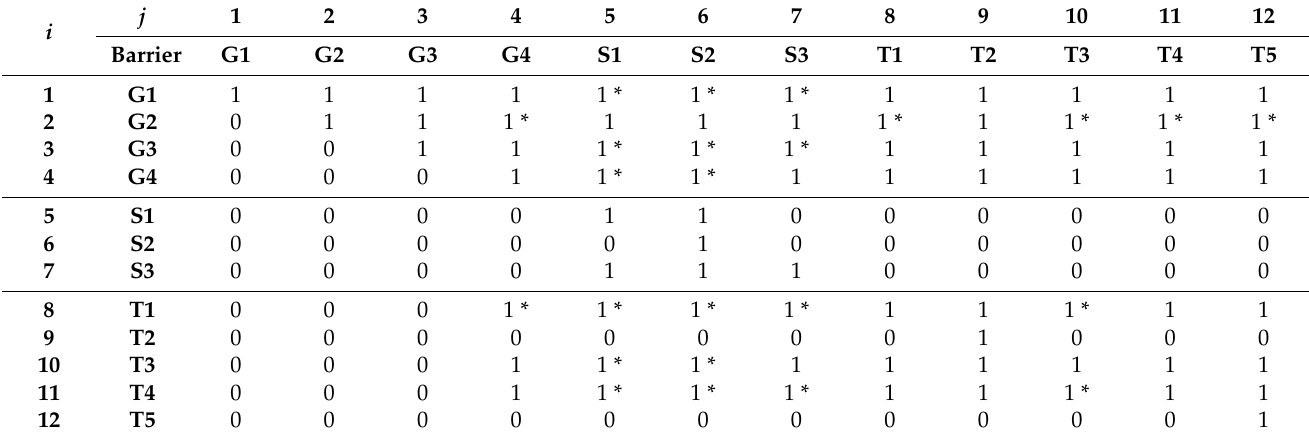
Table A3. Final Reachability Matrix (RM fin ) (Conventional Method).